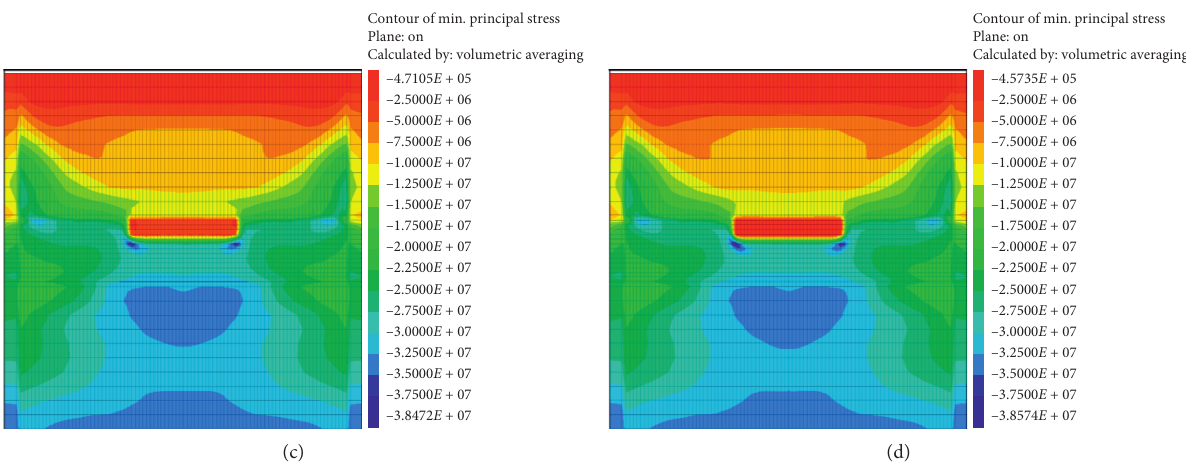
Figure 7: The maximum principal stress distribution cloud diagram of the four schemes (the contour of min. principal stress shown in FLAC code is the max. principal stress). (a) Scheme (I). (b) Scheme II. (c) Scheme III. (d) Scheme